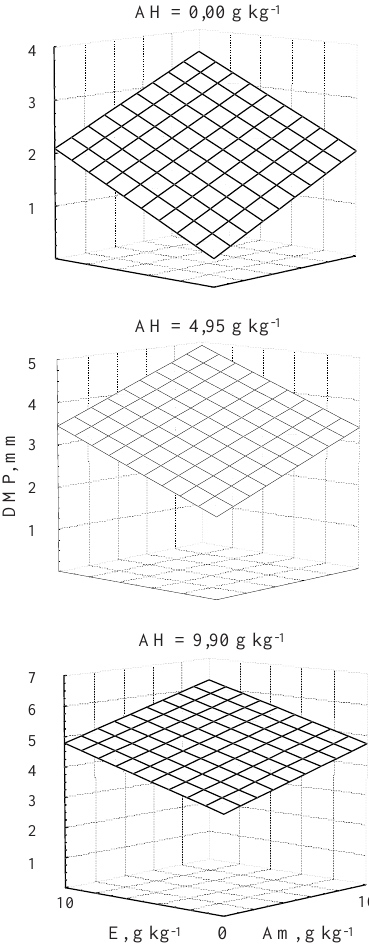
Figura 1. Diâmetro médio ponderado (DMP) dos agregados do horizonte A analisado por via seca, considerando a adição de amido (Am) e ácido esteárico (E), para diferentes doses de ácido húmico